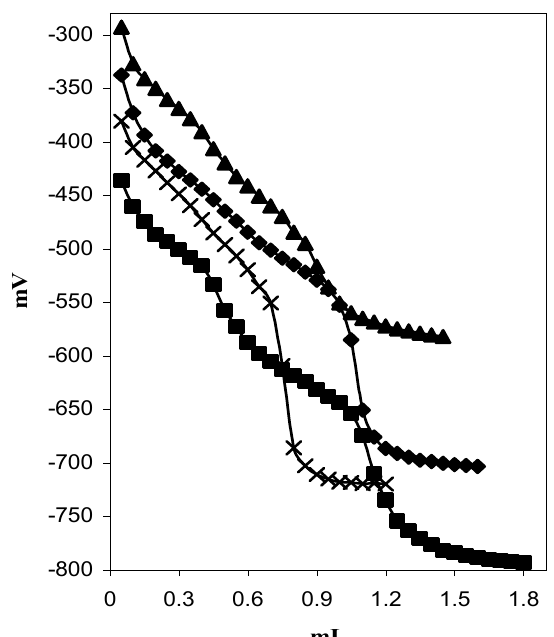
Figure 1. Potentiometric titration curves of 0.001 M solutions of compound 3d titrated with 0.05 M TBAH in isopropyl alcohol ( ▲ ), tert -butyl alcohol ( (cid:176) ), acetonitrile ( (cid:161) ) and N,N -dimethylformamide ( ■ ) at 25°C.